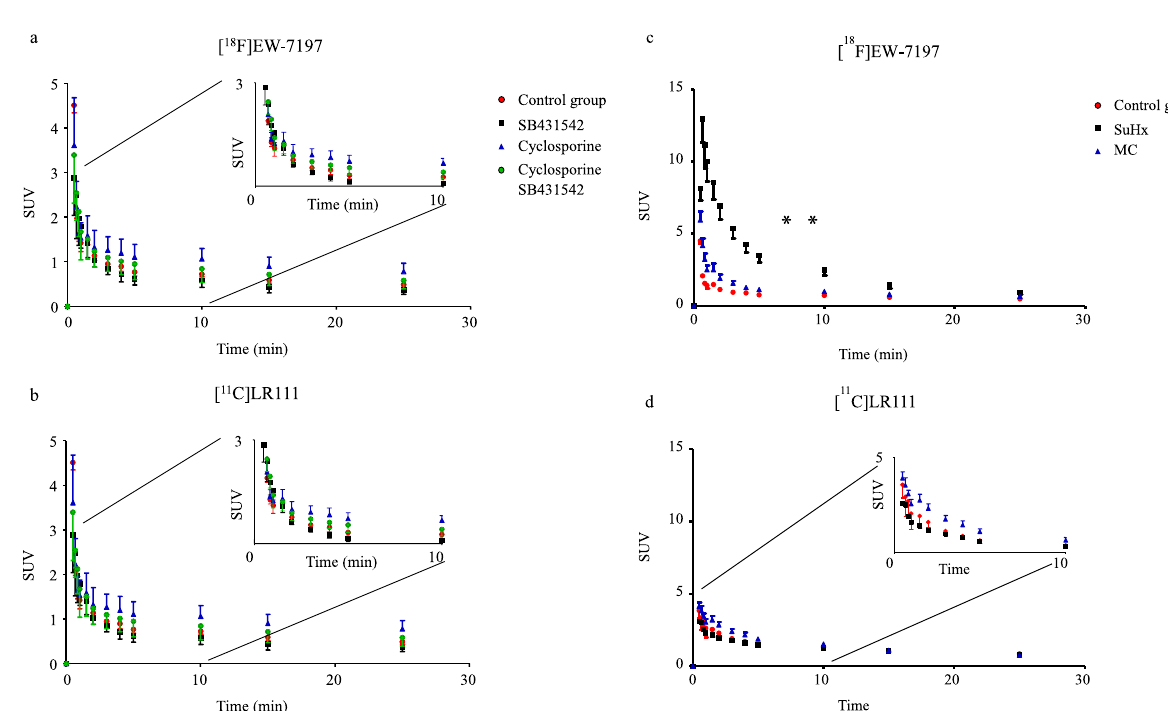
Fig. 8 Time activity curves of [ 18 F]EW-7197 ( a ) and [ 11 C]LR111 ( b ) in healthy male Wistar rats ( n conditions (black line), efflux pump blocked conditions (blue line), efflux pump blocked and ALK5 blocked condition (green line). Time activity curves of [ 18 F]EW-7197 ( c ) and [ 11 C]LR111 ( d ) in healthy male Wistar rats (red line, n lungs (black line, n 5) under baseline =